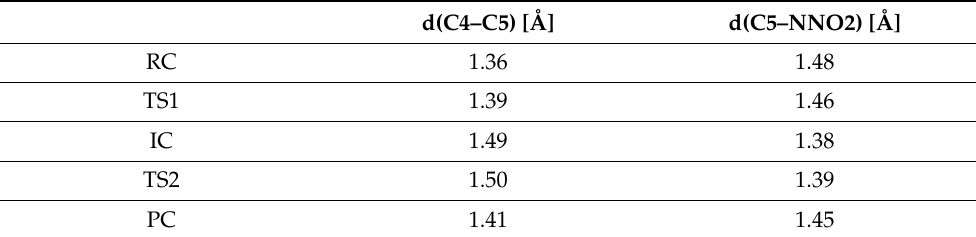
Table 1. C 4 –C 5 and C 5 –N NO2 bond lengths (Angstrom) during the reactive